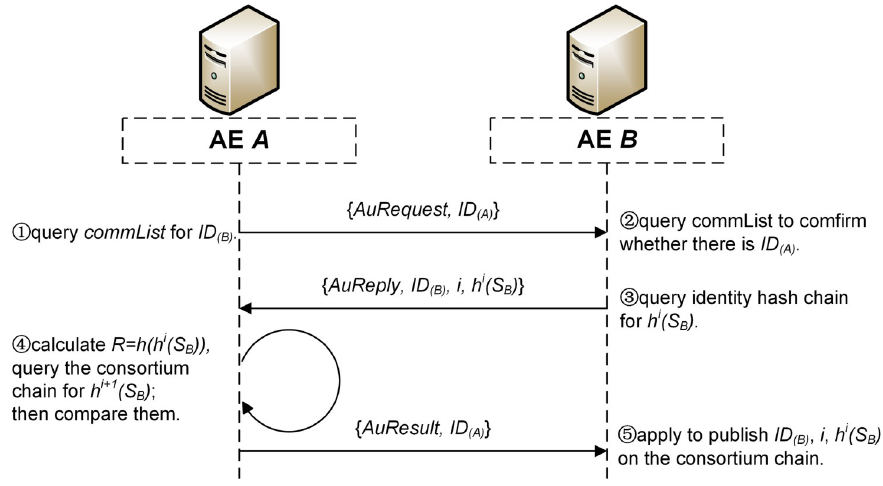
Fig 9. The process of identity